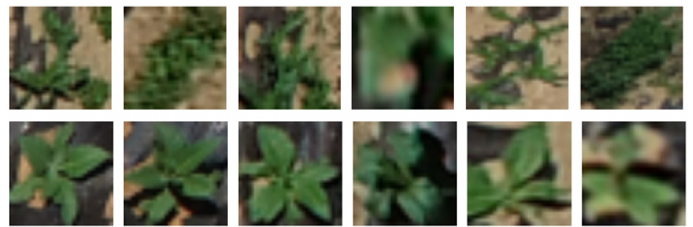
Figure 7. Training samples selected by IoU (Intersection over Union). The top row shows the negative samples and the bottom row shows the positive ones.